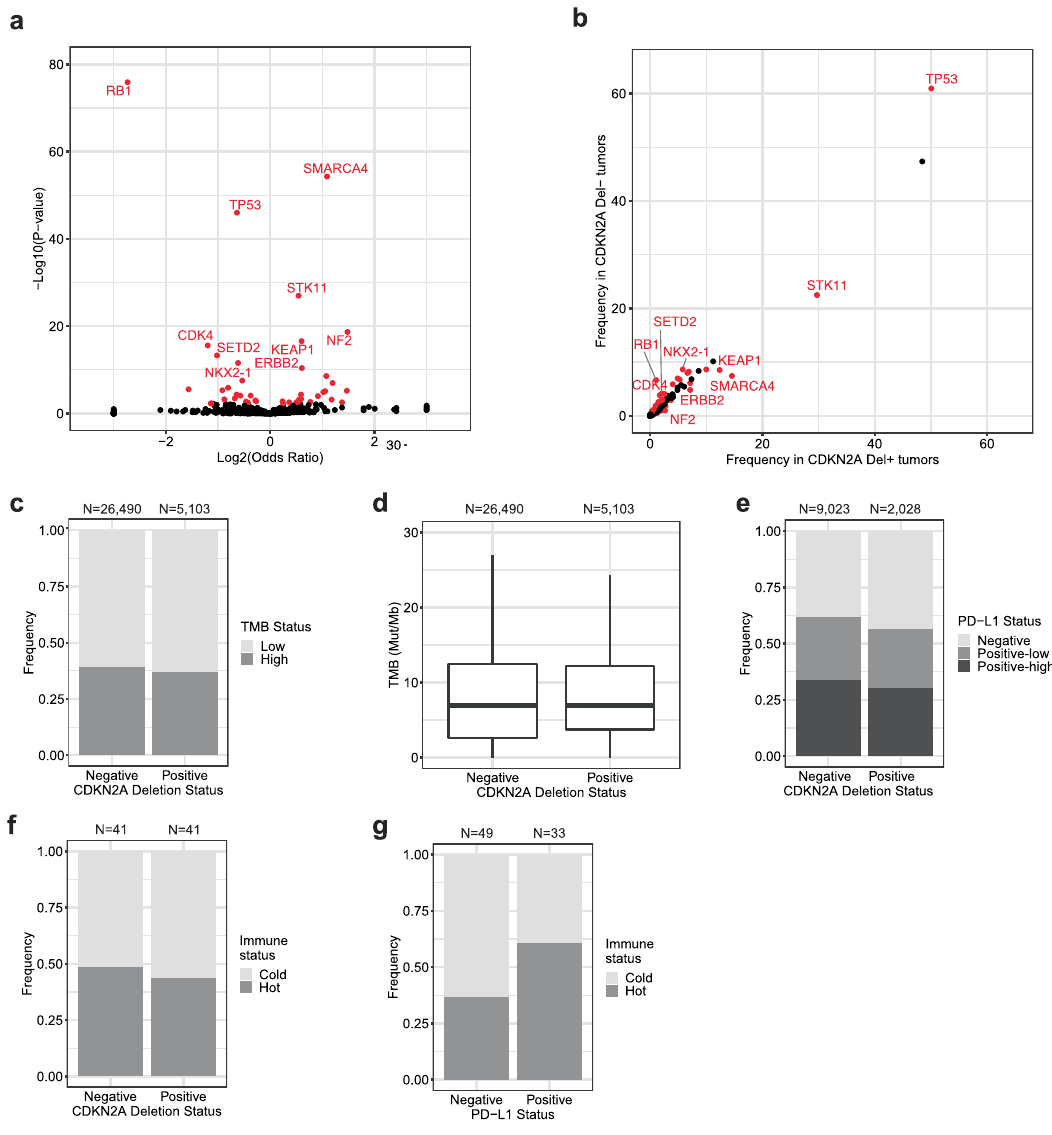
Fig. 4 Biomarker associations with CDKN2A deletion in EGFR / ALK - lung adenocarcinoma specimens. a Volcano plot demonstrating genomic enrichment according to CDKN2A deletion status. b Scatter plot of gene frequencies in CDKN2A del + tumors versus CDKN2A del − tumors. Fisher ’ s exact test was used to calculate the odds ratio and p -value for the association between gene alteration and CDKN2A deletion. Genes with a positive odds ratio are more frequently altered in CDKN2A del + (versus CDKN2A del − ) samples and genes with a negative odds ratio are more frequently altered in CDKN2A del − (versus CDKN2A del + ) samples. Signi fi cant genes after Benjamini – Hochberg correction (FDR p -value < 0.05) are colored in red. The top ten genes according to p -value are labeled. CDKN2B and MTAP are not included. c Bar chart showing frequency of TMB-high ( ≥ 10 mut/Mb) and TMB-low (<10 mut/Mb) tumors by CDKN2A deletion status. d Box plot of TMB values by CDKN2A deletion status. The boxplot shows the 1st and 3rd quartiles (upper and lower bounds), 2nd quartile (center), and minimum and maximum values (1.5*interquartile range, whiskers). Outliers are excluded. e Bar chart showing frequency of PD-L1-positive and PD-L1-negative tumors by CDKN2A deletion status. f Bar chart showing frequency of immune hot and cold tumors by CDKN2A deletion status. g Bar chart